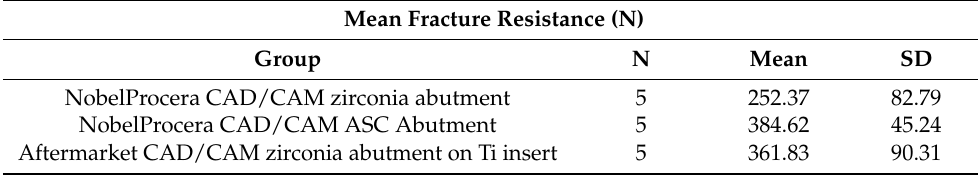
Table 2. Mean fracture resistance of zirconia abutments.